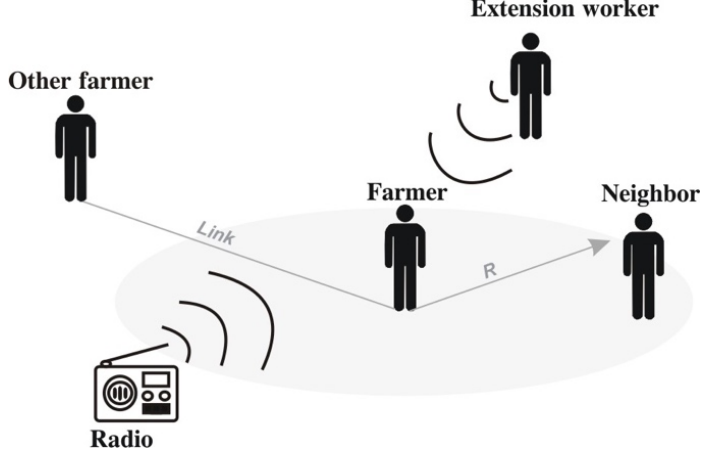
Figure 4. Description of agents’ communication about weather forecast information in the community. Farmers interact with nearby farmers within their radius distances of interaction and links through networking. Agriculture extension workers visit the farmers to exchange weather forecast information. Farmers receive information from radios on a daily basis. Figure is adapted from [64]. Table 2. Information flow through agent